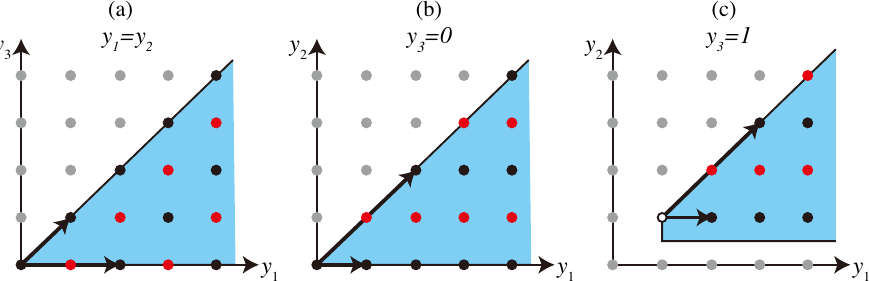
FIG. 9. W ð i;d Þ ’ s in SG 150. (a) W ð 1 ; 0 Þ in the y 1 ¼ y 2 plane. (b) W ð 4 ; 0 Þ in the y 3 ¼ 0 plane. In panels (a) and (b), the polyhedral cone W ð i; 0 Þ is represented by the shaded area, the generators of ¯ W ð i; 0 Þ are represented by the bold black arrows, the points in ¯ W ð i; 0 Þ are represented by black dots, and the points in Z 3 ∩ W ð i; 0 Þ − polyhedron W ð 4 ; 1 Þ is represented by the shaded area, the points (only one) in the set ¯ W ð 4 ; 1 Þ are represented by black dots, and the points in Z 3 ∩ W ð 4 ; 1 Þ − in